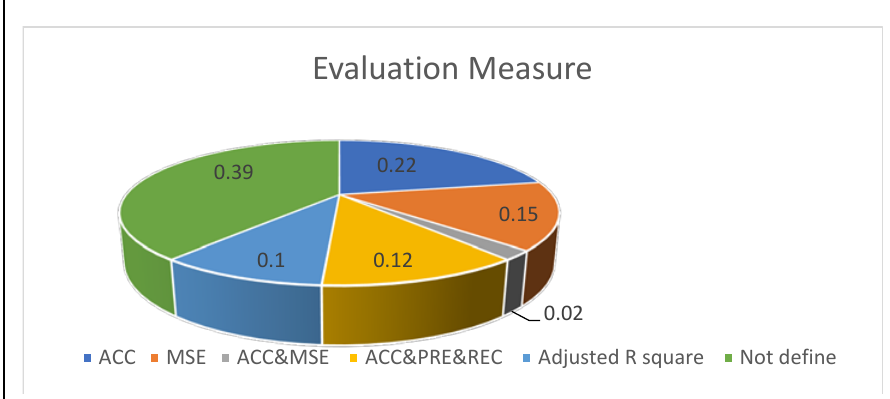
Figure 12. Evaluation measure of intelligent computing models.